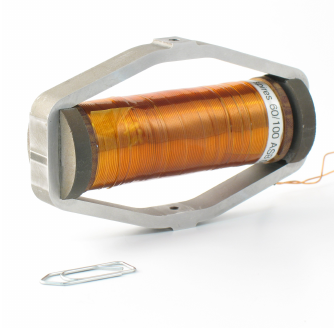
Figure 6. The shell-like actuator commercially proposed by [44].